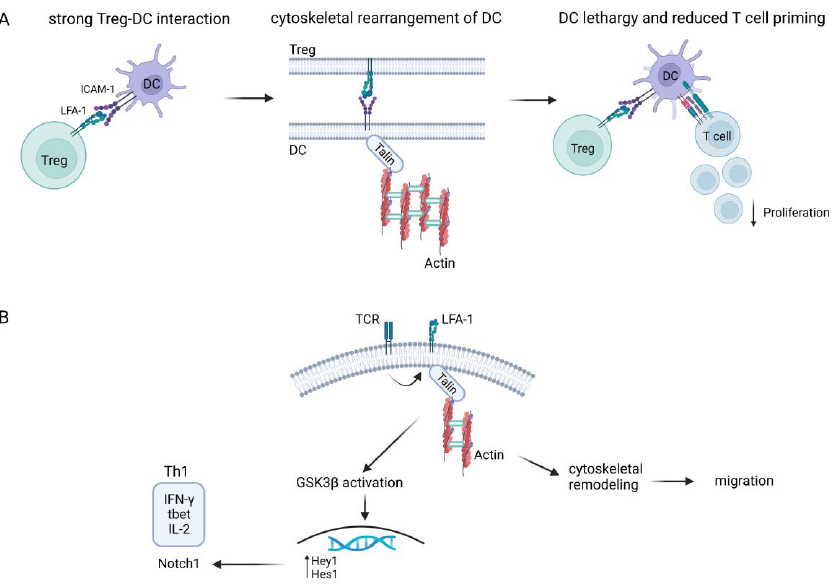
Figure 1. Role of LFA-1-mediated contact for T cell response and suppression. ( A ) LFA-1-mediated suppression of T cells. Long-lasting high-affinity contact between Treg and DC via LFA-1-ICAM-1 interaction activates the cytoskeletal rearrangement of Fascin-1-dependent actin polarization in DC. This conformational change causes DC lethargy, preventing T cell proliferation and activation. This mechanistic control of T cell activation emphasizes Treg-mediated DC suppression via LFA-1 con- tact [50]. ( B ) Th1 response in T cells is driven by LFA-1 signaling. TCR inside-out signaling leads to the binding of Talin-1 to the β 2 - tail of LFA-1, enabling its high-affinity activation. Following this, LFA-1 triggers downstream signaling pathways that control cytoskeletal rearrangement and the mi- gration of activated T cells. LFA-1 also induces glycogen synthase kinase (GSK)3β-dependent Notch1 activation and the production of Th-1-related cytokines and transcription factors [7,52,53] (created with BioRender.com (accessed on 7 March 2023).